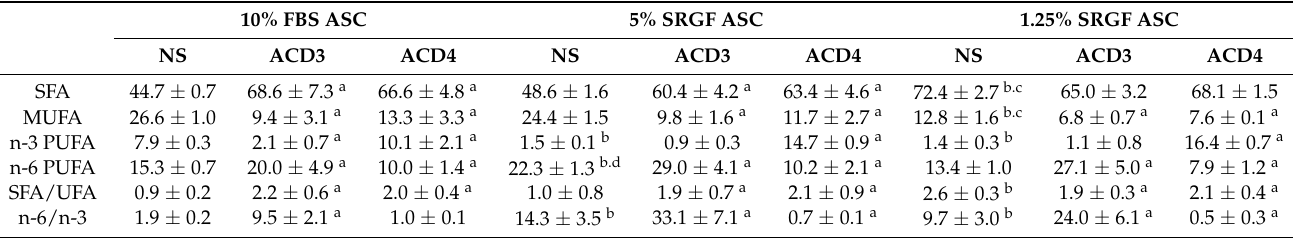
Figure 4. Figure 4 shows fluorescent nanoparticle uptake efficiency in 10% FBS, 5% SRGF and 1.25% SRGF ASC. Both 50 nm and 120 nm beads were administered to expanded ASC labelled by CFDA-SE. Representative images as well as evaluation of mean fluorescence intensity as arbitrary units (M.F.I. (a.u.)) were reported. Scale bars: 30 µ m *; p < 0.01 vs. 5% SRGF ASC and vs. 1.25 % SRGF ASC. Reported images and mean quantification values represent results derived from at least three independent experimental tests. Table 1. ASC lipid membrane